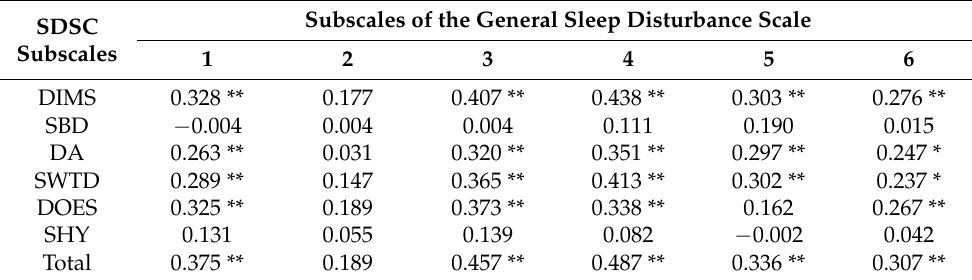
Table 5. Correlation between SDSC and sleep disorders of parents as measured with